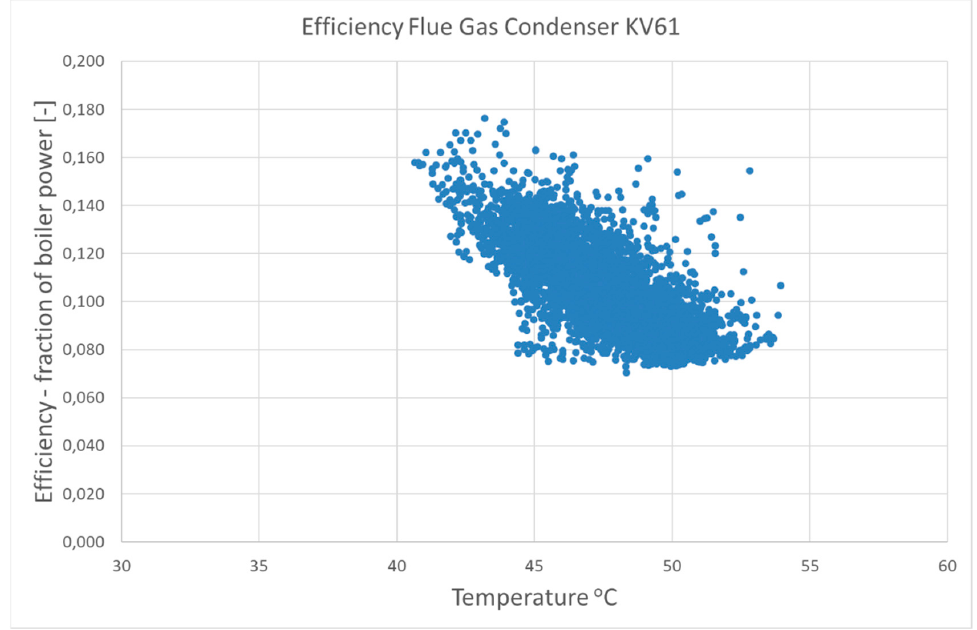
Figure 10. Flue gas condenser efficiency for KV 61 waste incineration unit. Samples are collected during several years and during different operation modes. There are variations in boiler power, fuel moisture, outdoor pressure, and so on. This gives a great data dispersion, but the temperature trend is clear. Table 6. Temperature-dependent efficiencies in the MODEST model (Y = efficiency as fraction of boiler power; X = temperature [°C]).